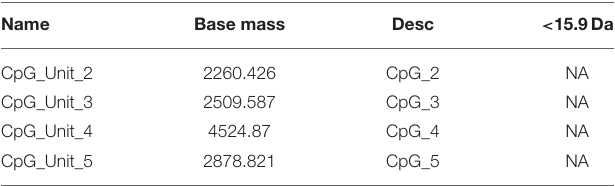
ENCODE and Roadmap Epigenetics data can be used to select regions of interest. The popular UCSC and ENSEMBL genome browser are not always up to date with the latest ENCODE and Roadmap data. ENCODE has an excellent UCSC portal by